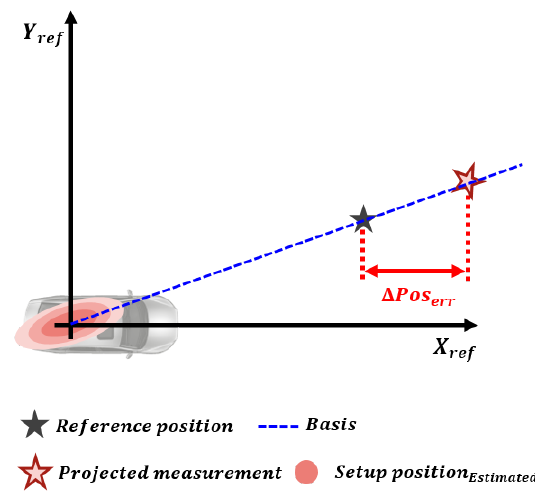
Figure 6. Origin position error estimated by the projection